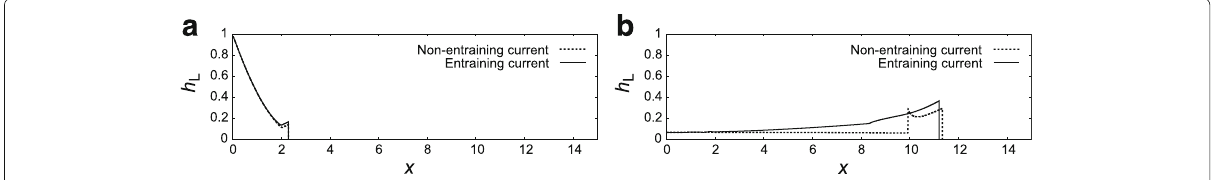
Fig. 10 Numerical results of a one-layer dilute PDC model for the dam-break problem. Heights h L at a t = 1 and b t = 10 are shown for cases of entraining ( solidcurves ) and non-entraining ( dottedcurves ) currents. The initial density ratio ( ρ ∗ variables are non-dimensionalized using the initial values (e.g., Eqs. (4) and (5)). Given parameters: aspect ratio (initial height/initial length) = 1; initial particle concentration = 0.005; density ratio (particles/air) = 1500; density ratio (volcanic gas/air) = 1; and non-dimensional particle settling speed = 0.05